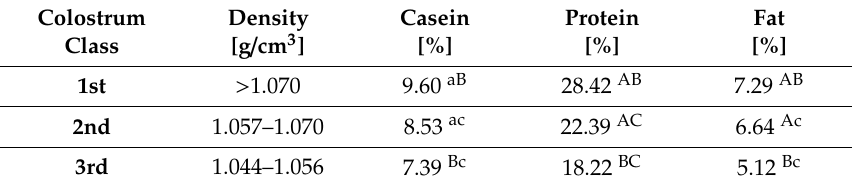
Table 2. The division of cows’ colostrum into classes, taking into account the basic parameters: Casein, protein, and fat.